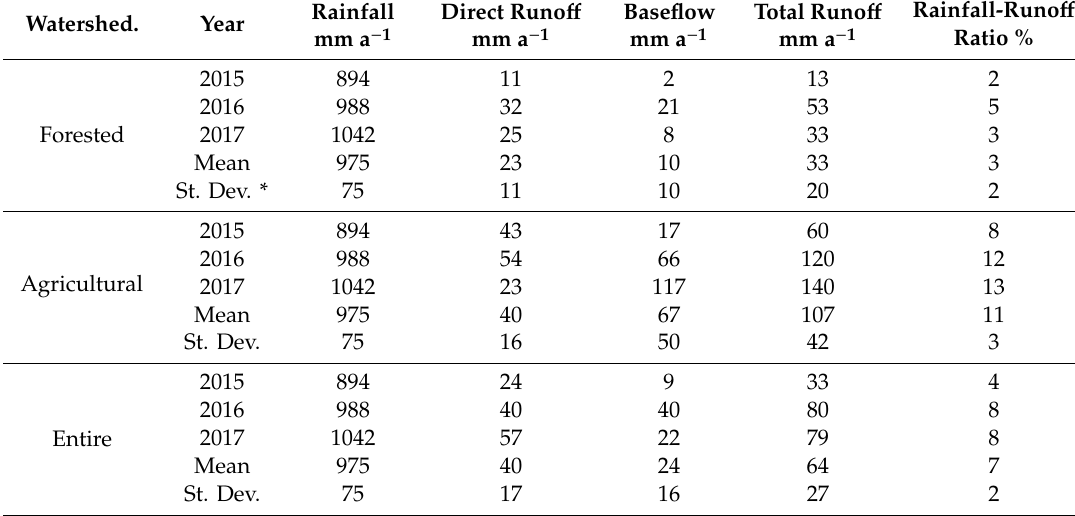
* Standard deviation.